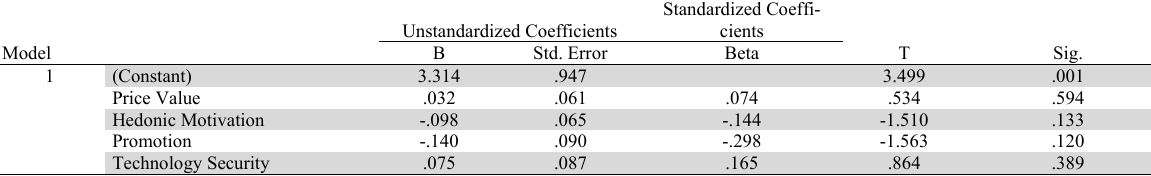
Heteroscedasticity Test Results Model